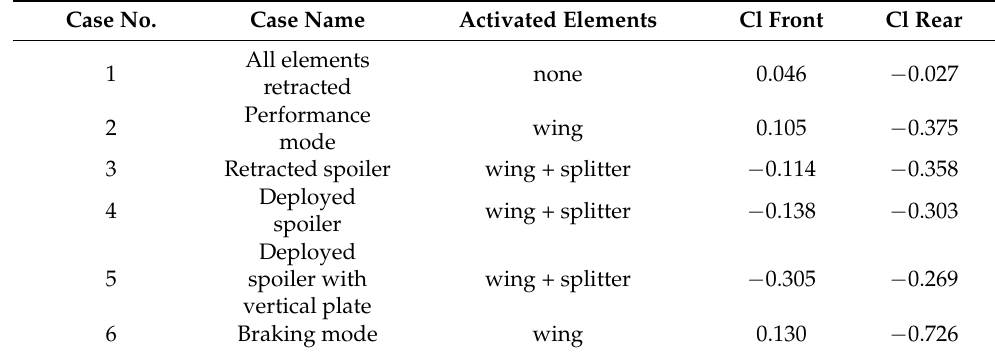
Table 5. Load distribution of the lift coefficient (Cl) for previously presented results. Case No. Case Name Activated Elements Cl Front Cl Rear All elements 1 none 0.046 − 0.027 retracted Performance